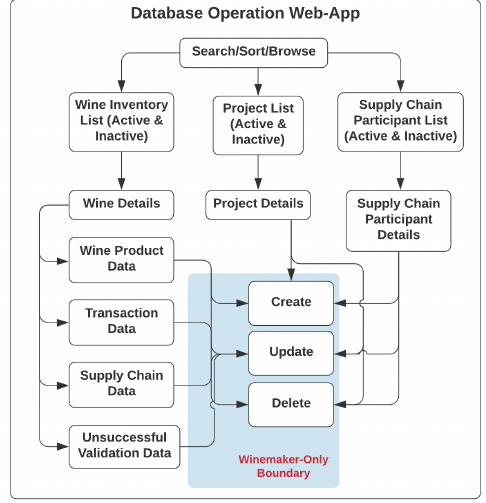
Figure 4. Use Cases of Database Web